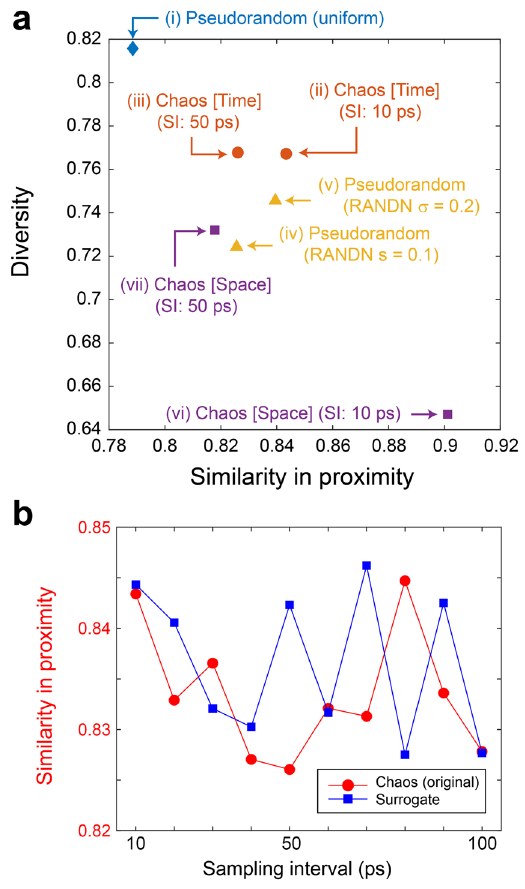
Figure 4. Analysis of the generated images. ( a ) Scatter plot of the similarity of the generated images upon a slight change in the latent variable, called the similarity in proximity, and the diversity of the generated images overall. ( b ) Similarity in proximity as a function of the SI of the laser chaos sequences. The minimum peak value occurs at 50 ps, which corresponds to the maximum negative autocorrelation at 50 ps in the original laser chaos (see Fig. 2). With the surrogate chaos sequences, obtained by eliminating the temporal structure from the original chaos sequence, no such tendency is observable.